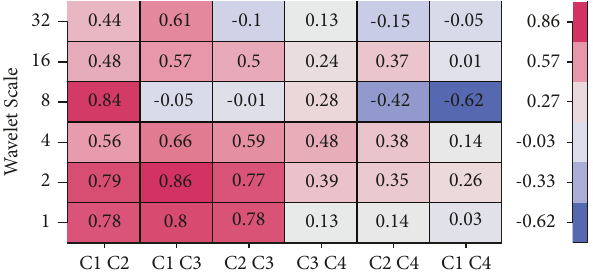
Figure 14: Wavelet multiple correlation between overall systematic risk of Emerging Markets (18/08/2010–03/11/2020). The blue lines denote upper (U) and lower limits (L) of the 95% confidence interval,